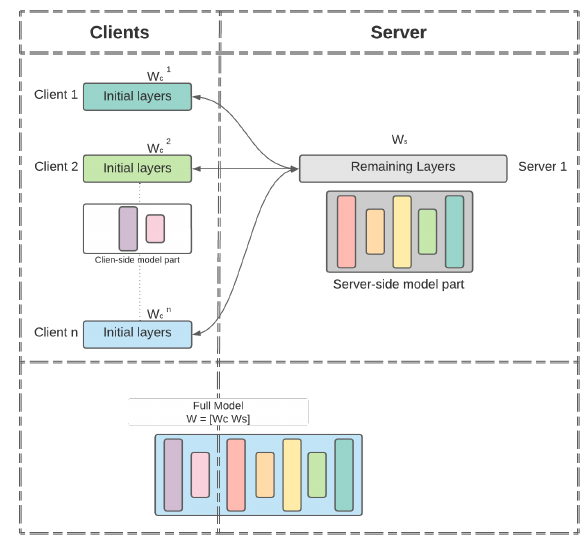
Figure 1. Multi-head-split-learning